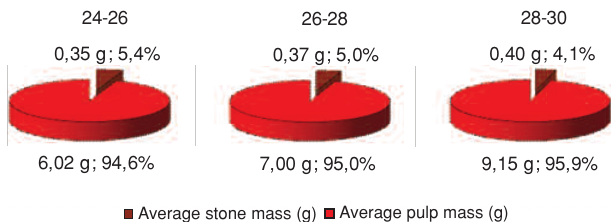
Fig. 19 T he stone-pulp ratio of Canada Giant in the individual